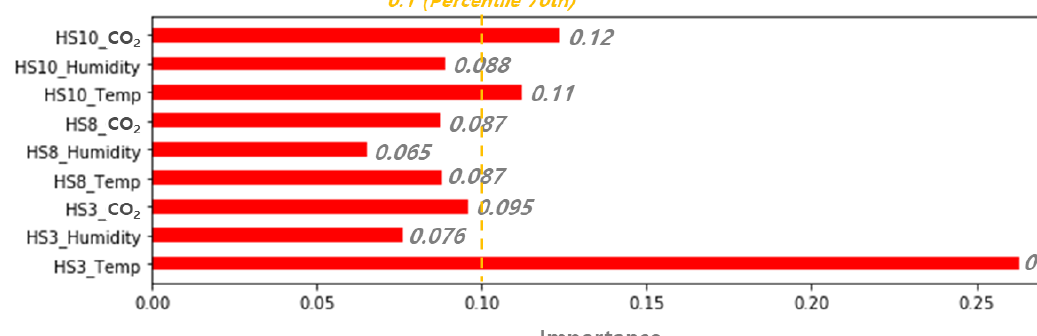
Figure 6. Gini importance of indoor environmental data.